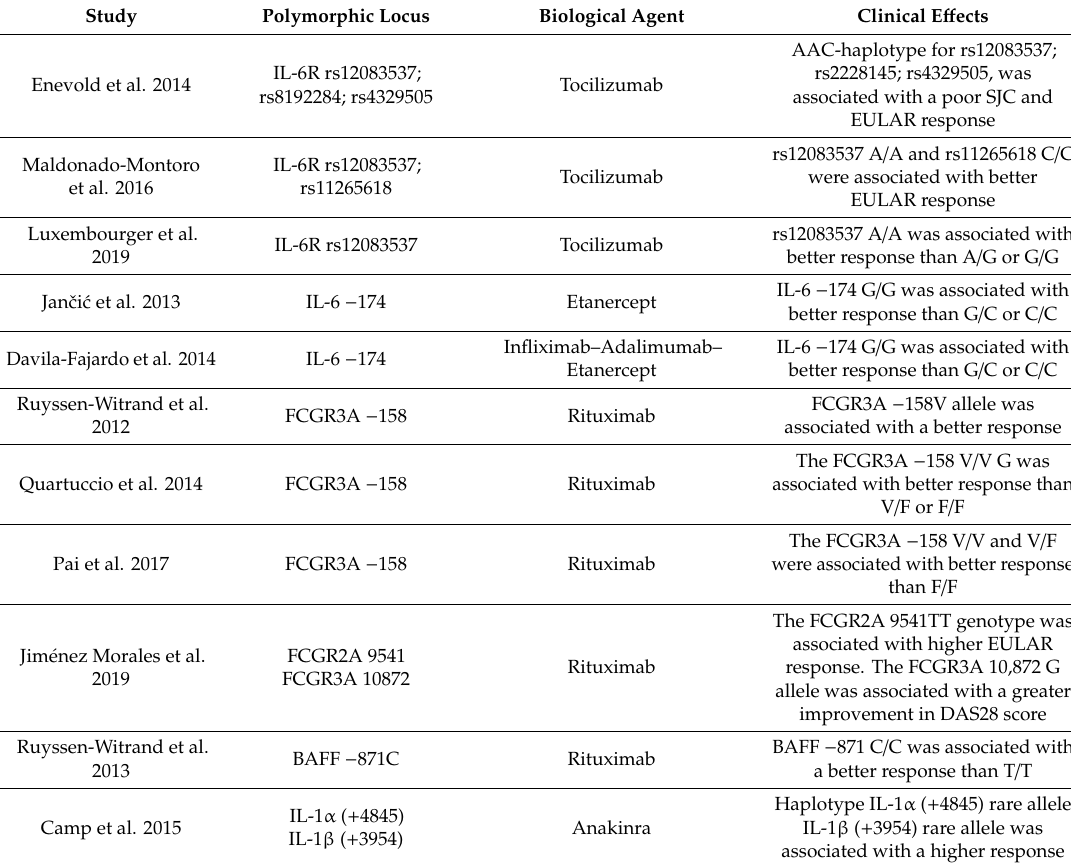
Table 2. Summary of studies on pharmacogenetics of anti-Interleukin-6, anti-CD20, anti-Interleukin-1 treatments in